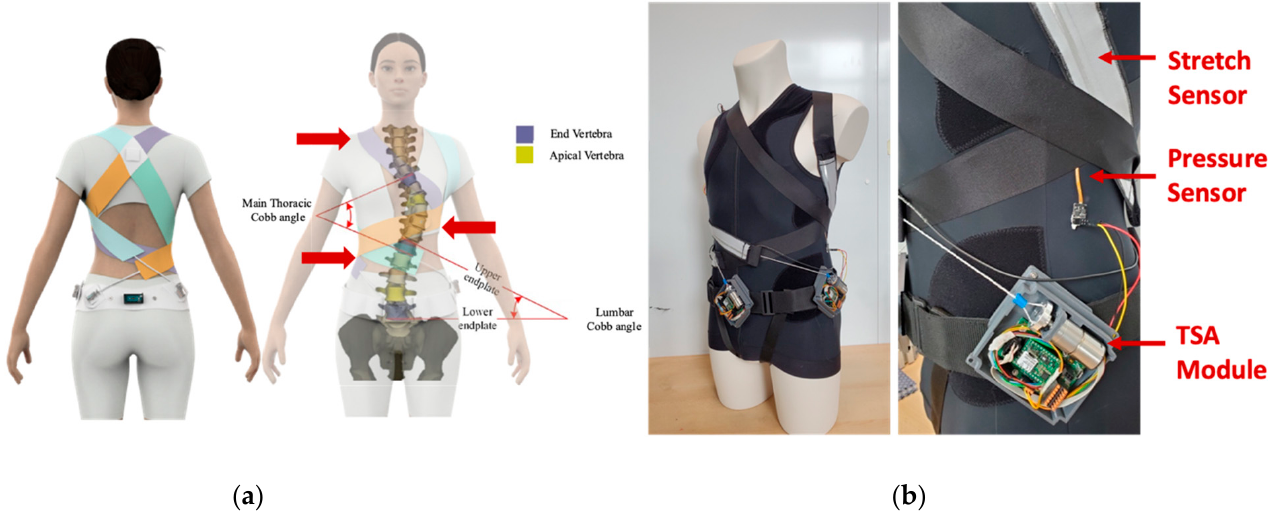
Figure 1. Active soft brace design and prototype. ( a ): conceptual design with scoliotic spine descrip- tion; ( b ): prototype with actuator module, bands and stretch sensor .